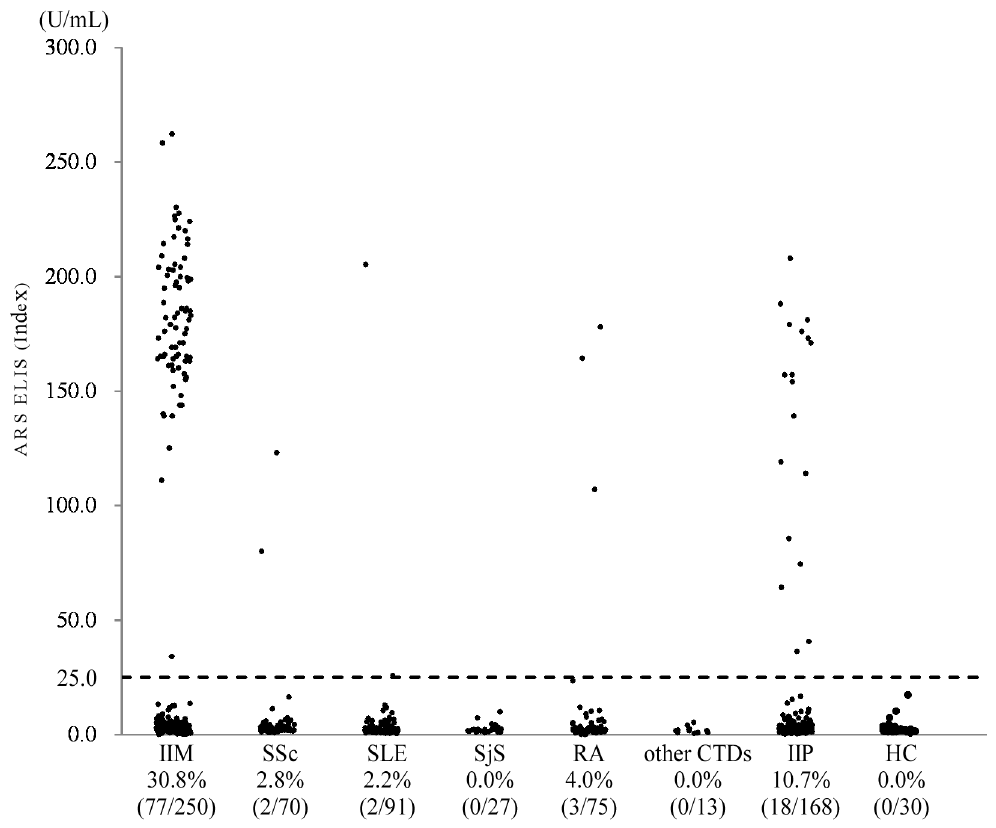
Figure 2. Confirmation of the efficiency of the ELISA system. Using the ELISA system, ARS antibodies were measured in 694 serum samples from patients with various CTDs and IIP, and 30 serum samples from healthy controls. The cutoff value (25 U/mL) is indicated by a horizontal dotted